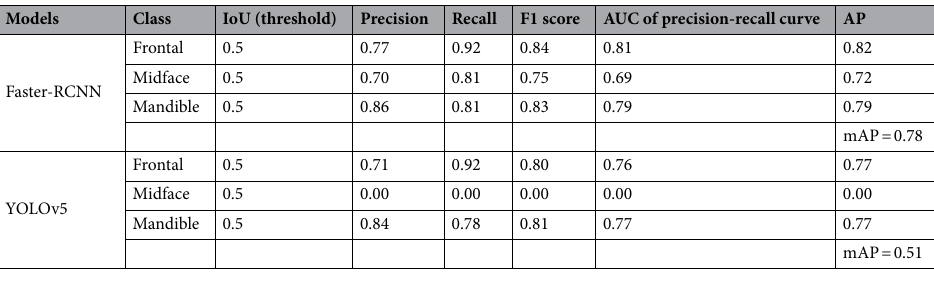
Table 2. Multiclass object detection performances of faster R-CNN and YOLOv5 for identification of maxillofacial fracture in each class. IoU intersection over union, AUC area under the precision-recall curve, AP average precision, mAP mean average precision.